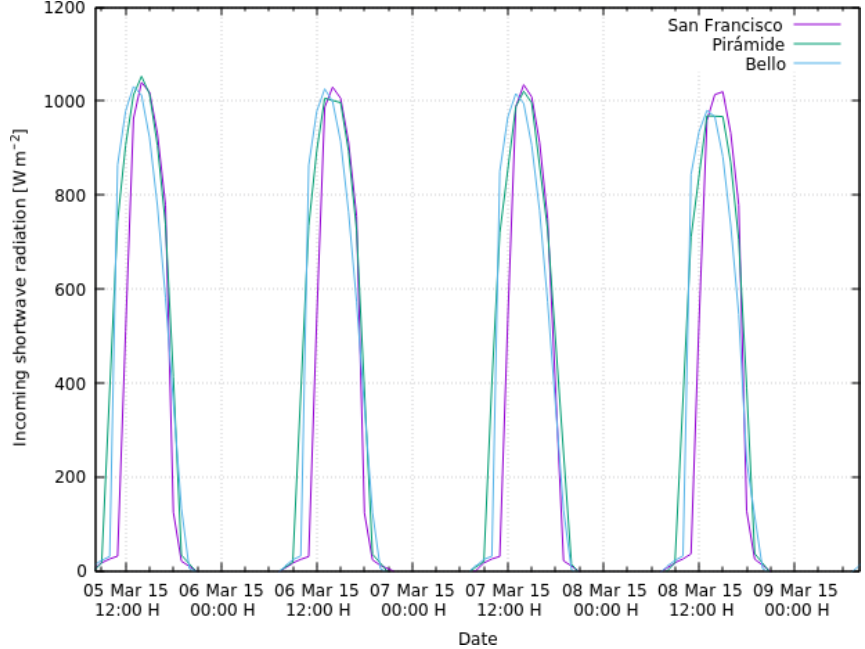
Figure A1. Incoming shortwave radiation at the AWSs installed on Bello, Pirámide and San Francisco glaciers during March 2016.